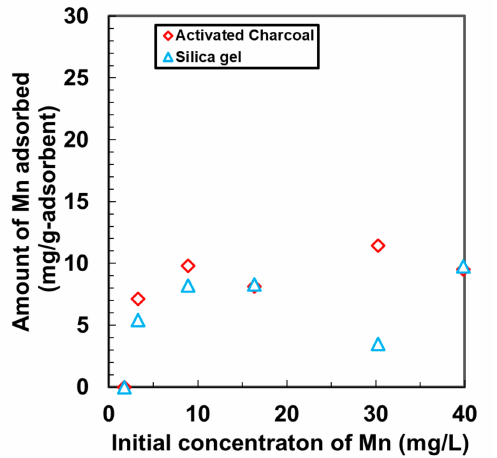
Figure 7. Adsorption of Mn by activated charcoal and silica